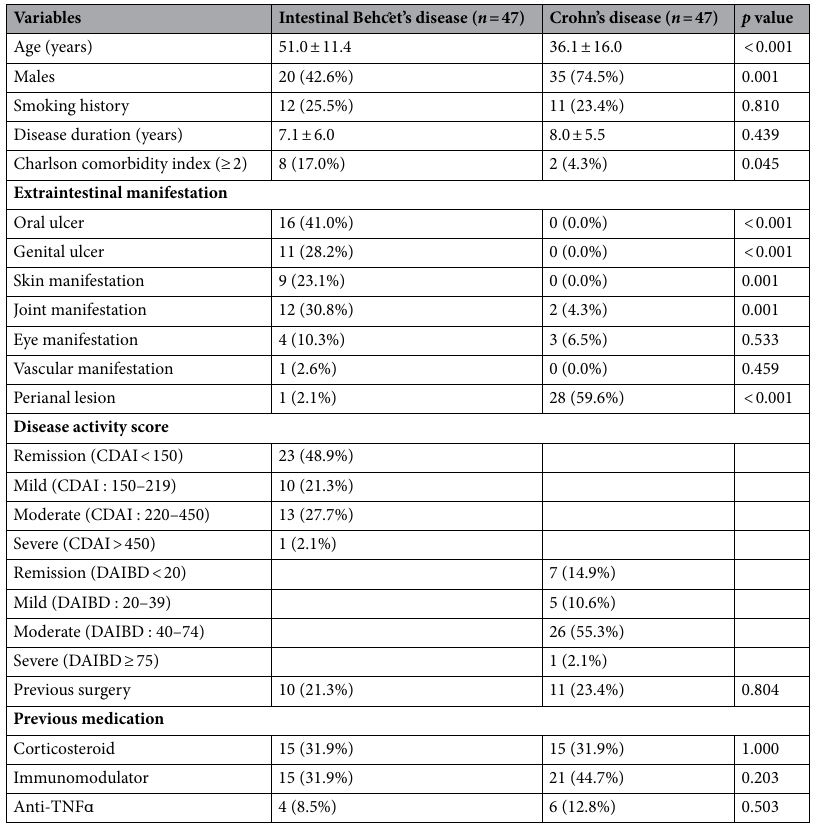
Table 1. Baseline characteristics of the study patients. Variables are expressed as mean ± SEM or n (%). BD Beh ƈ et’s disease, CD Crohn’s disease, TNF tumor necrosis factor, CDAI Crohn’s disease activity index, DAIBD disease activity index of Beh ƈ et’s disease, SD standard